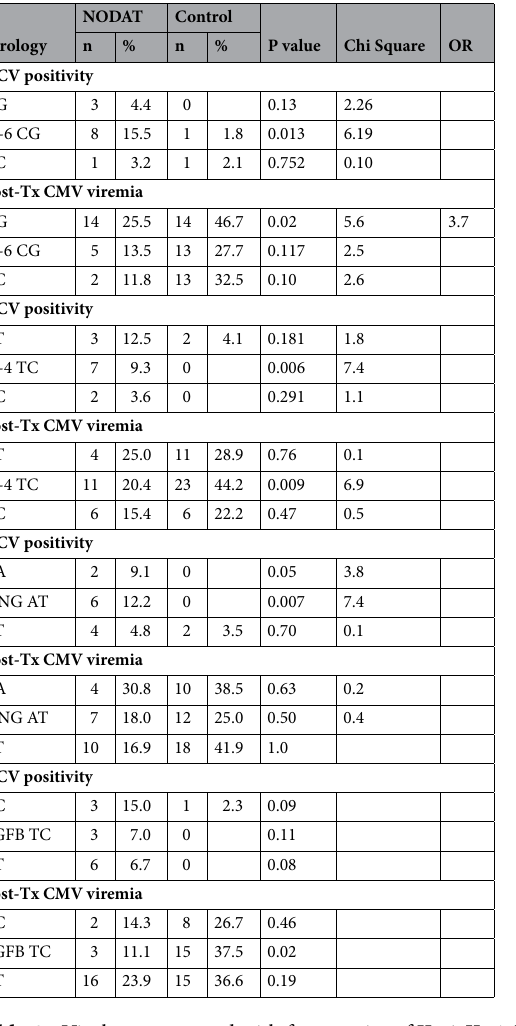
Table 4. Virology compared with frequencies of IL-6, IL-4, IFNG and TGFB in NODAT versus control. IL-6 CG was more frequent in NODAT than control, p = 0.03; while IL-6 GG showed to be more frequent among control than NODAT, p = 0.003 in post-transplant CMV. IL-4 TC also was more frequent in NODAT than control, p = 0.006. On the other hand, IL-4 TC was more frequent on control than NODAT, p = 0.009. IFNG AA and AT were more frequent among NODAT compared to control in HCV positive individuals, p = 0.05, 0.007 respectively. While post-transplant CMV was not associated to the disease, TGFB did not show any statistically significant association with NODAT nor control in HCV positive individuals. While TGFB TC was significantly more in control subjects, p =